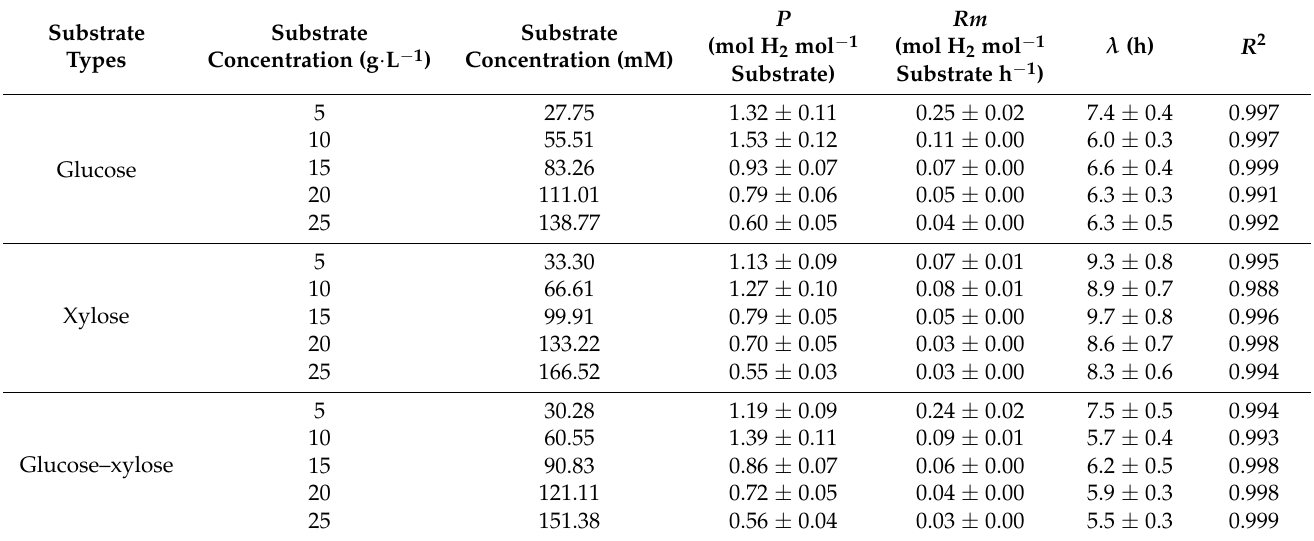
Table 2. Estimated bio-hydrogen production potential ( P ) and maximum bio-hydrogen production rate ( Rm ) from glucose, xylose, and glucose–xylose at varying